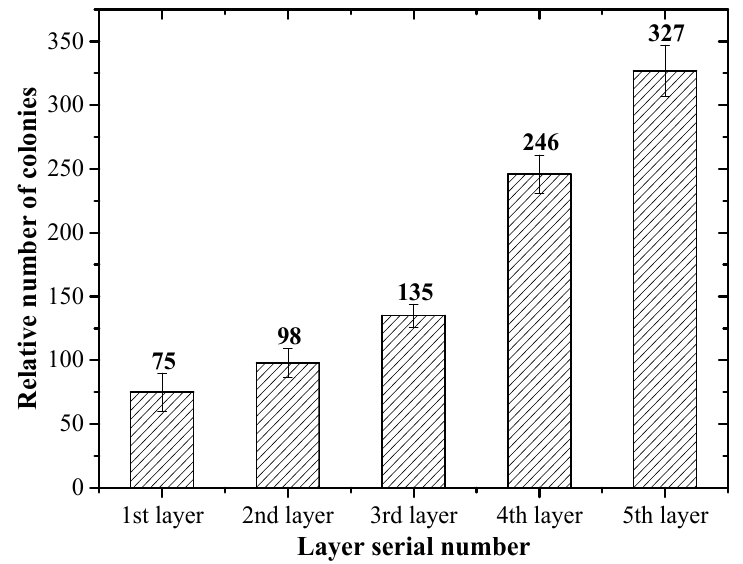
Figure 11. Numbers of the E. coli colonies of the side ‐ by ‐ side processed PA66 fabrics.